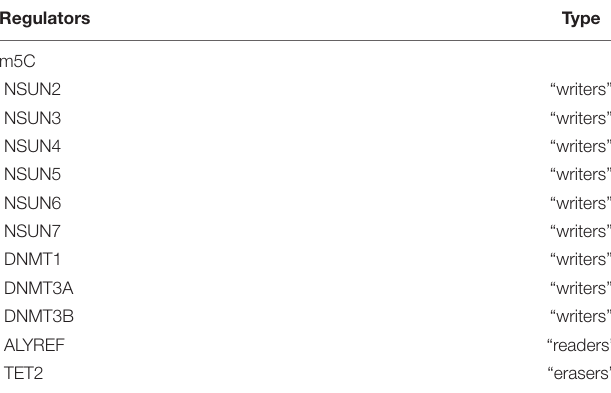
TABLE 2 | The list of the RNA modifying proteins involved in